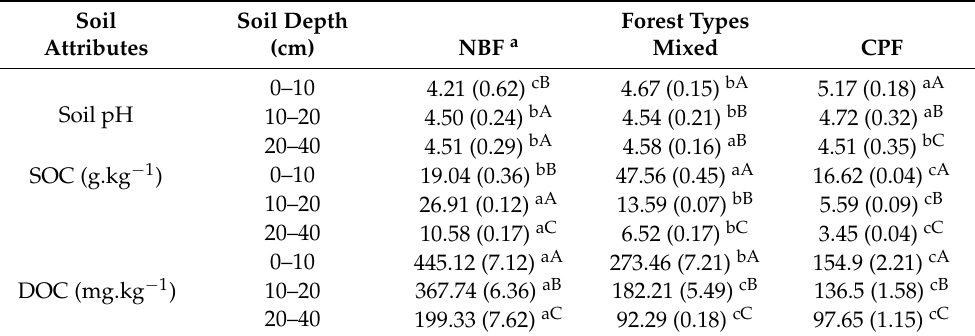
Table 1. Soil pH, soil organic carbon (SOC), and dissolved organic carbon (DOC) at three soil depths along NBF, mixed forest, and CPF stands. Values are the mean (SE in parentheses) of three replicates.